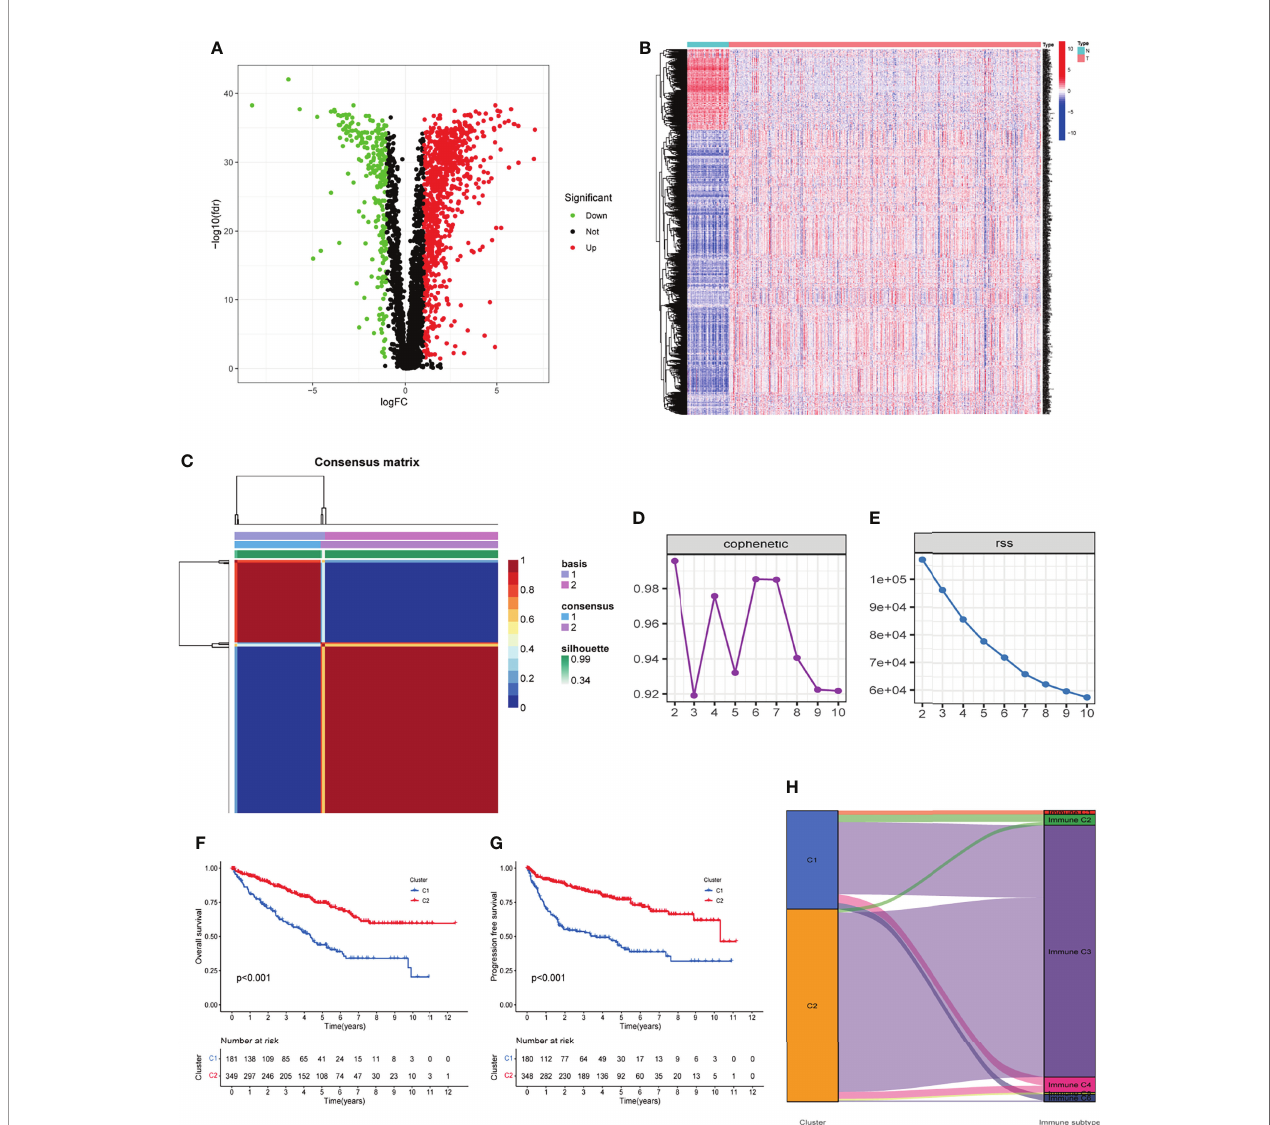
FIGURE 1 | Two clusters were identi fi ed based on TME-related differentially expressed genes. (A, B) Volcano and heatmap of the distribution of differentially expressed genes, with P < 0.05 and |log2 FC| > 1.0 as cut-off values. (C) Consensus map of 530 cases of KIRC via the NMF algorithm. (D, E) Factorization rank for k=2 – 10. (F, G) The Kaplan ‐ Meier survival curve showed the OS and PFS of the two subtypes of patients. (H) Percentage of the four immune subtypes accounting for each of the two clusters. TME, tumor microenvironment; KIRC, kidney renal clear cell carcinoma; NMF, non-negative matrix factorization; OS, overall survival; PFS, progression-free